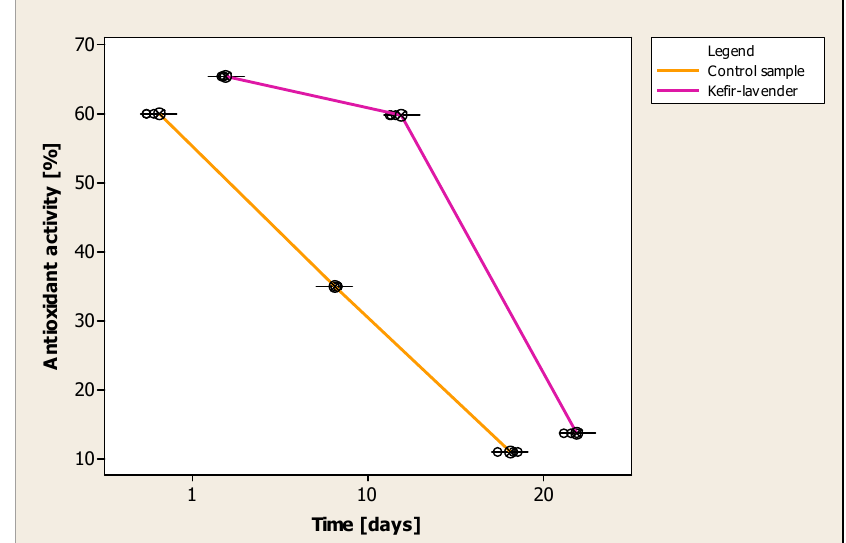
Figure 3. Comparative variation of antioxidant activity in kefir sample enriched with encapsulated lavender volatile oil and control sample.